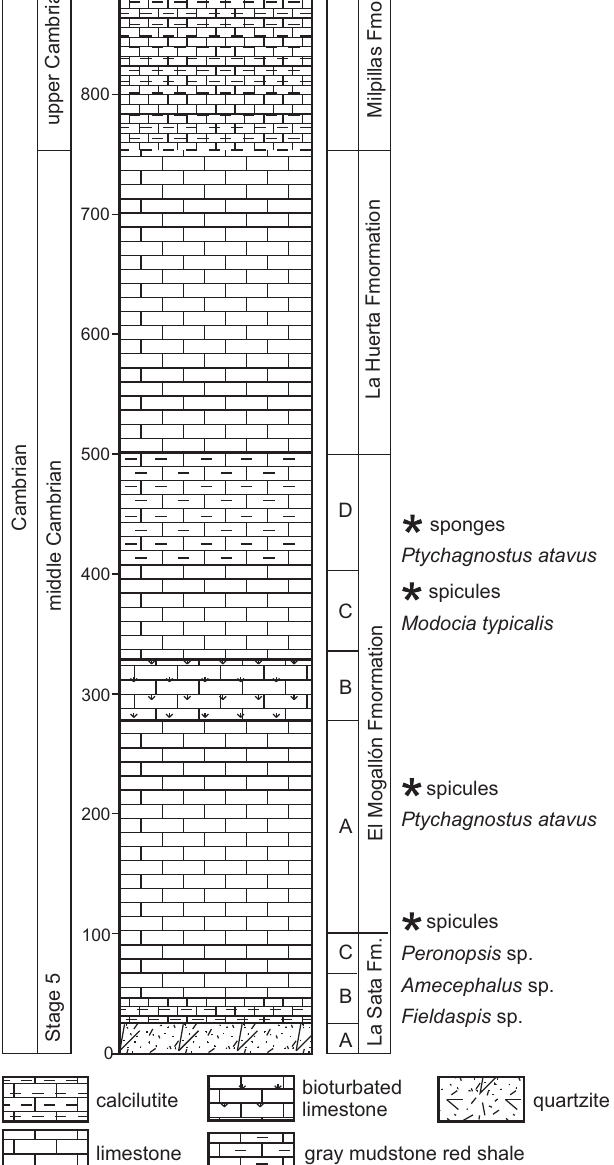
and Muir 2014), but the structure is fundamentally different to the double layer of Hintzespongia and allies. For these reasons, we prefer to leave the family-level assignment of Ratcliffespongia open. Stratigraphic and geographic range.— Recognised from the early Cambrian of China and Greenland, and the middle Cambrian of the Marjum and Weeler formations of Utah, USA, and Sonora, Mexico (this paper).